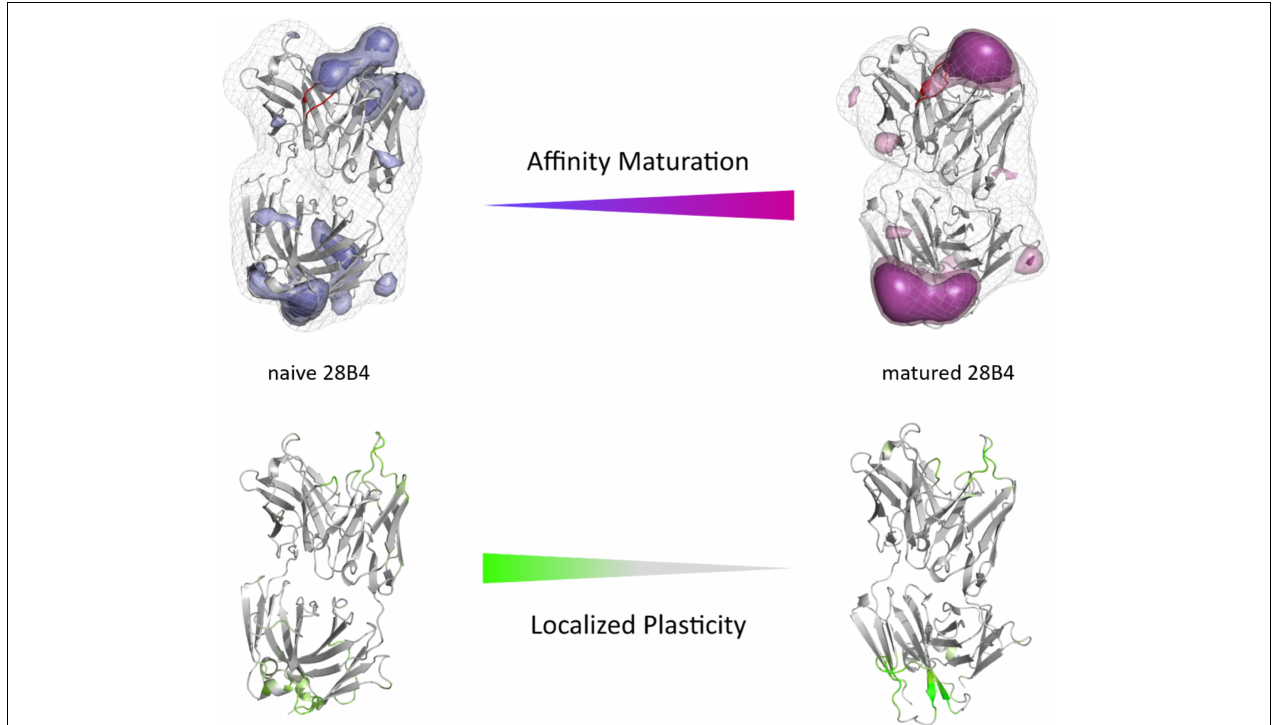
FIGURE 5 | Global (top) and localized (bottom) surface plasticity of the naive and matured 28B4 antibody Fab mapped onto a representative ensemble structure. (Top) Global plasticity of the naïve and the matured 28B4 antibody, highlighting the CDR-H3 loop in red. The intensity of the colors reflects the regions with higher plasticity and allows localization. (Bottom) Localized plasticity for both the naïve and the matured 28B4 antibody,